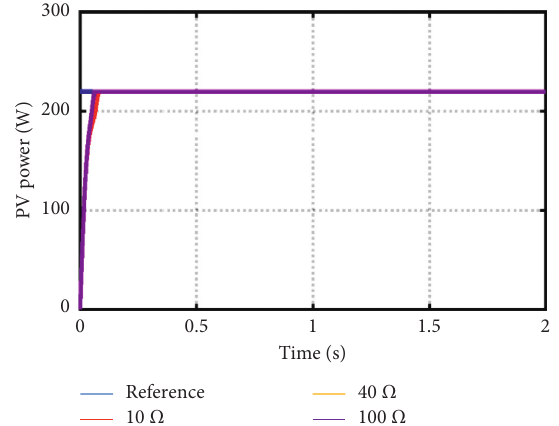
Figure 17: PV power responses for variable load (1000W/m 2 and 25 °